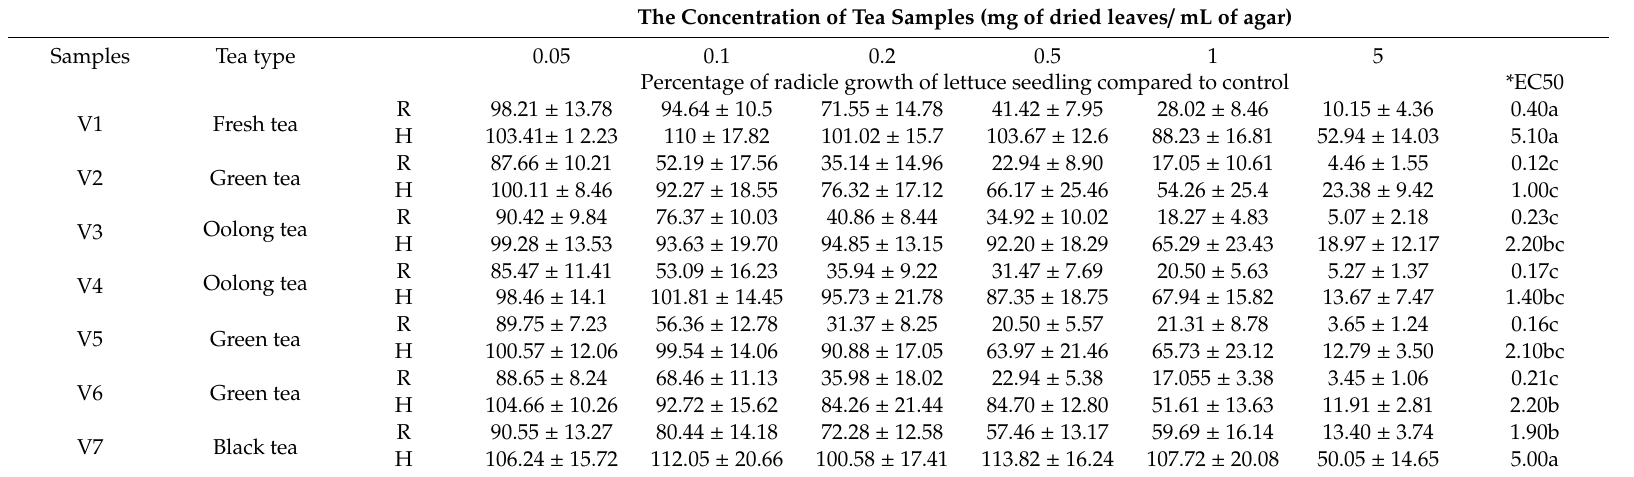
Table 1. The e ff ect of the phytotoxicity of tea samples on the growth of lettuce seedlings by the sandwich method. The Concentration of Tea Samples (mg of dried leaves / mL of